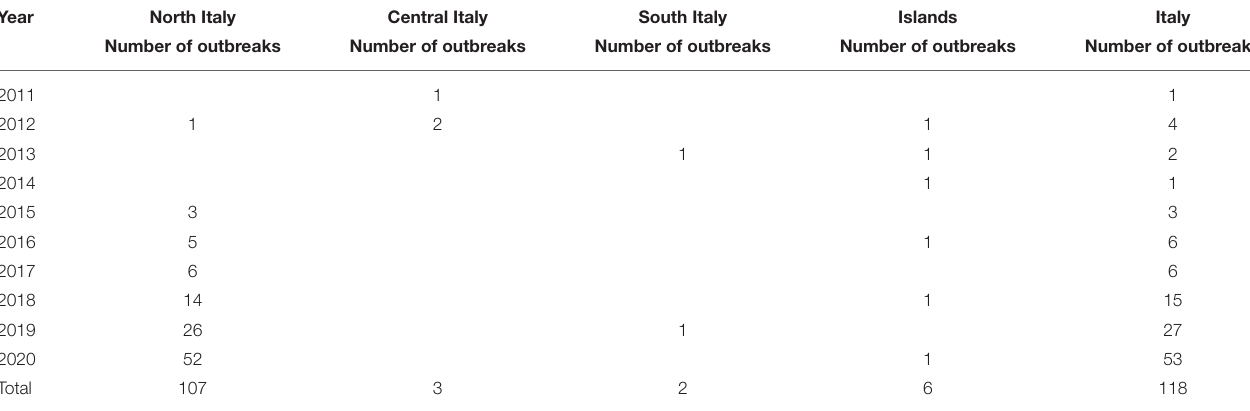
TABLE 7 | Number of Salmonella outbreaks notified in cattle, Italy, 2011–2020 (updated to